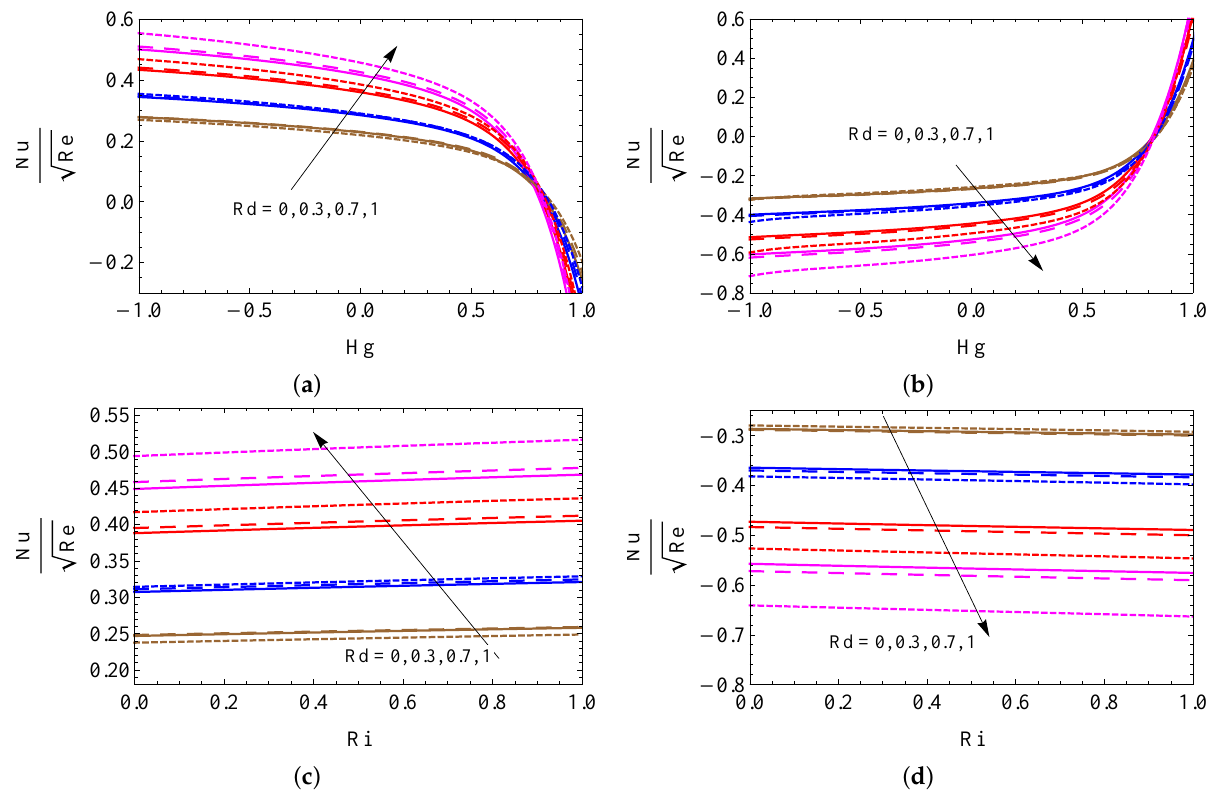
Figure 9. The contrast of LNN for different combinations of Rd and Hg ( a , b ) and Rd and Ri ( c , d ) with convective heating ( a , c ) and convective cooling ( b , d ) cases for SWCNTs (solid line), MWCNTs (dashed line) and Al 2 O 3 nanofluid (dotted